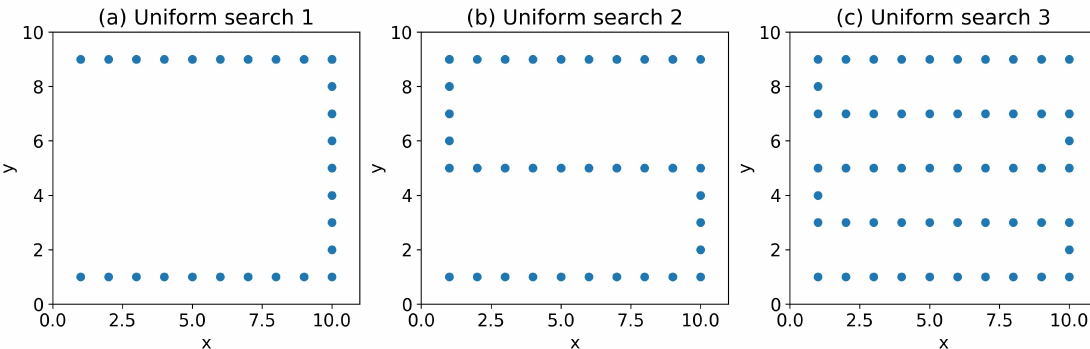
Figure A2. The uniform search algorithms with different searching densities. Each blue dot represents a position to take one measurement. From ( a ) to ( c ), their total search times are 28 s, 37 s, and 54 s